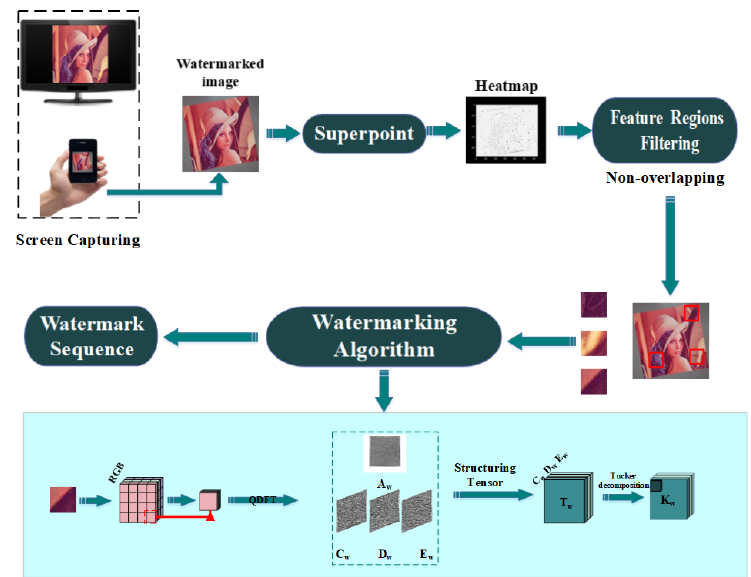
Figure 5. The architecture of the proposed extraction